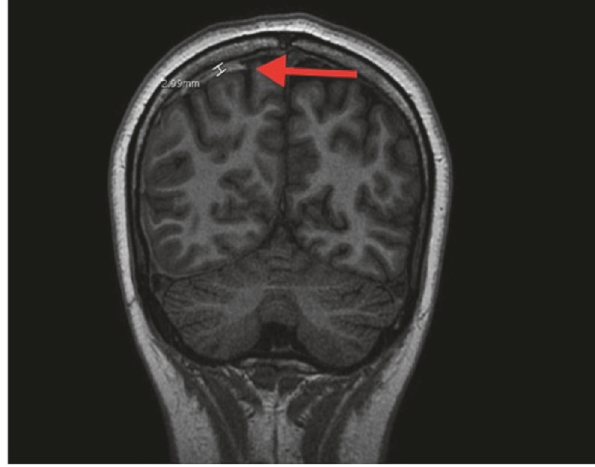
Figure 4: FSPGR sequence, coronal image of brain showing right parietal subdural